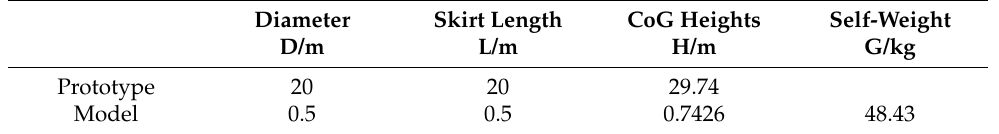
Figure 6. Schematic diagram of the test model. ( a ) TBJF model. ( b ) Schematic diagram of the TBJF. Table 2. Dimensions of the test model.